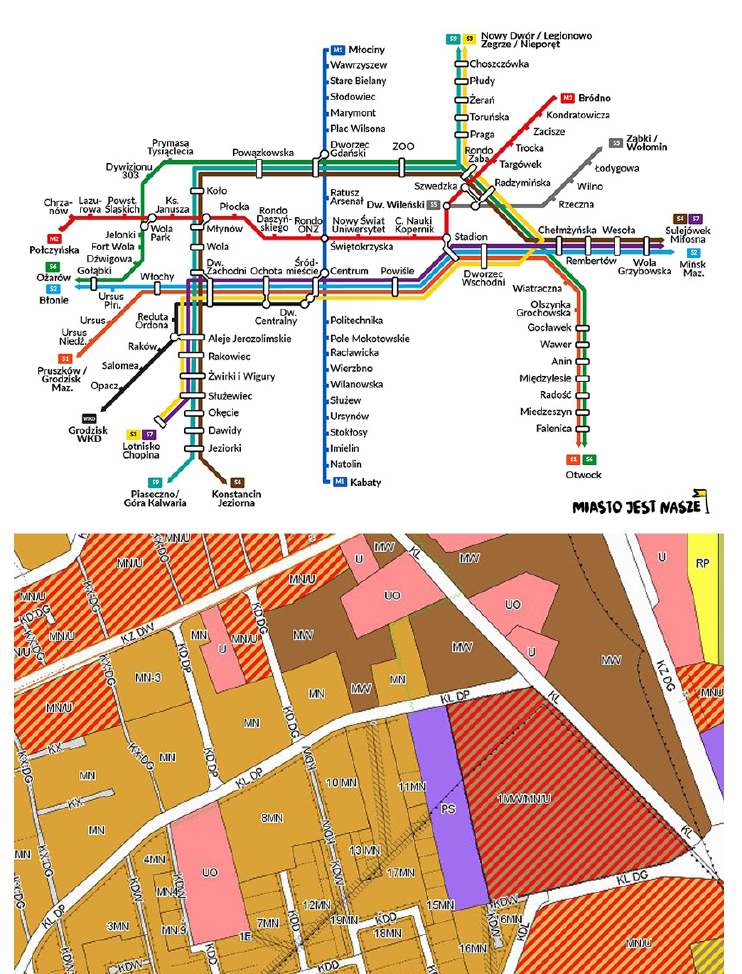
Fig. 1. Models of geographical theory. Meta map – functional scheme of communication in Warsaw (top), mega construct – part of the zoning map of Bełżyce (bottom) (miastojestnasze.org, geoportal.